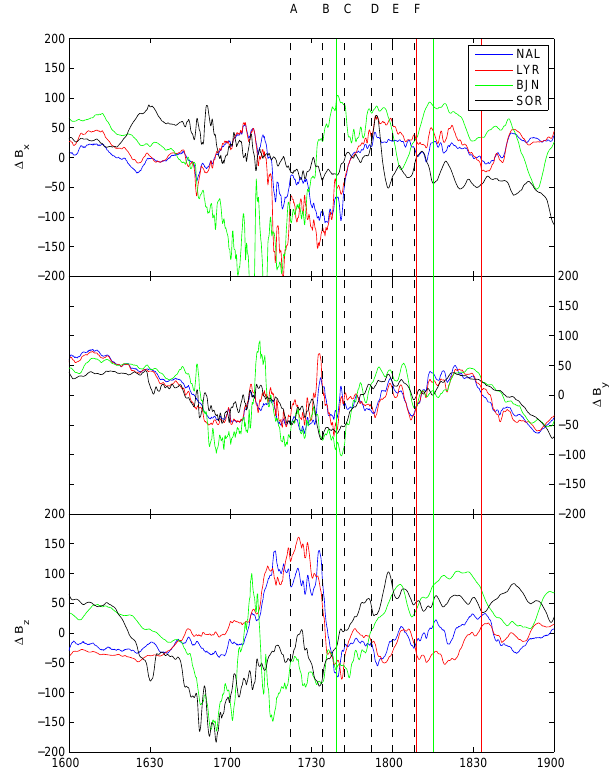
Fig. 9. The 1B X , 1B Y and 1B Z components of the IMAGE chaain For each trace the mean value over the 3h period is sub- tracted. The vertical dashed lines represent the times A through F at which SuperDARN measurements are shown in Fig. 10 and the solid vertical lines show the start and end times of the poleward motion of the aurora as in Fig.